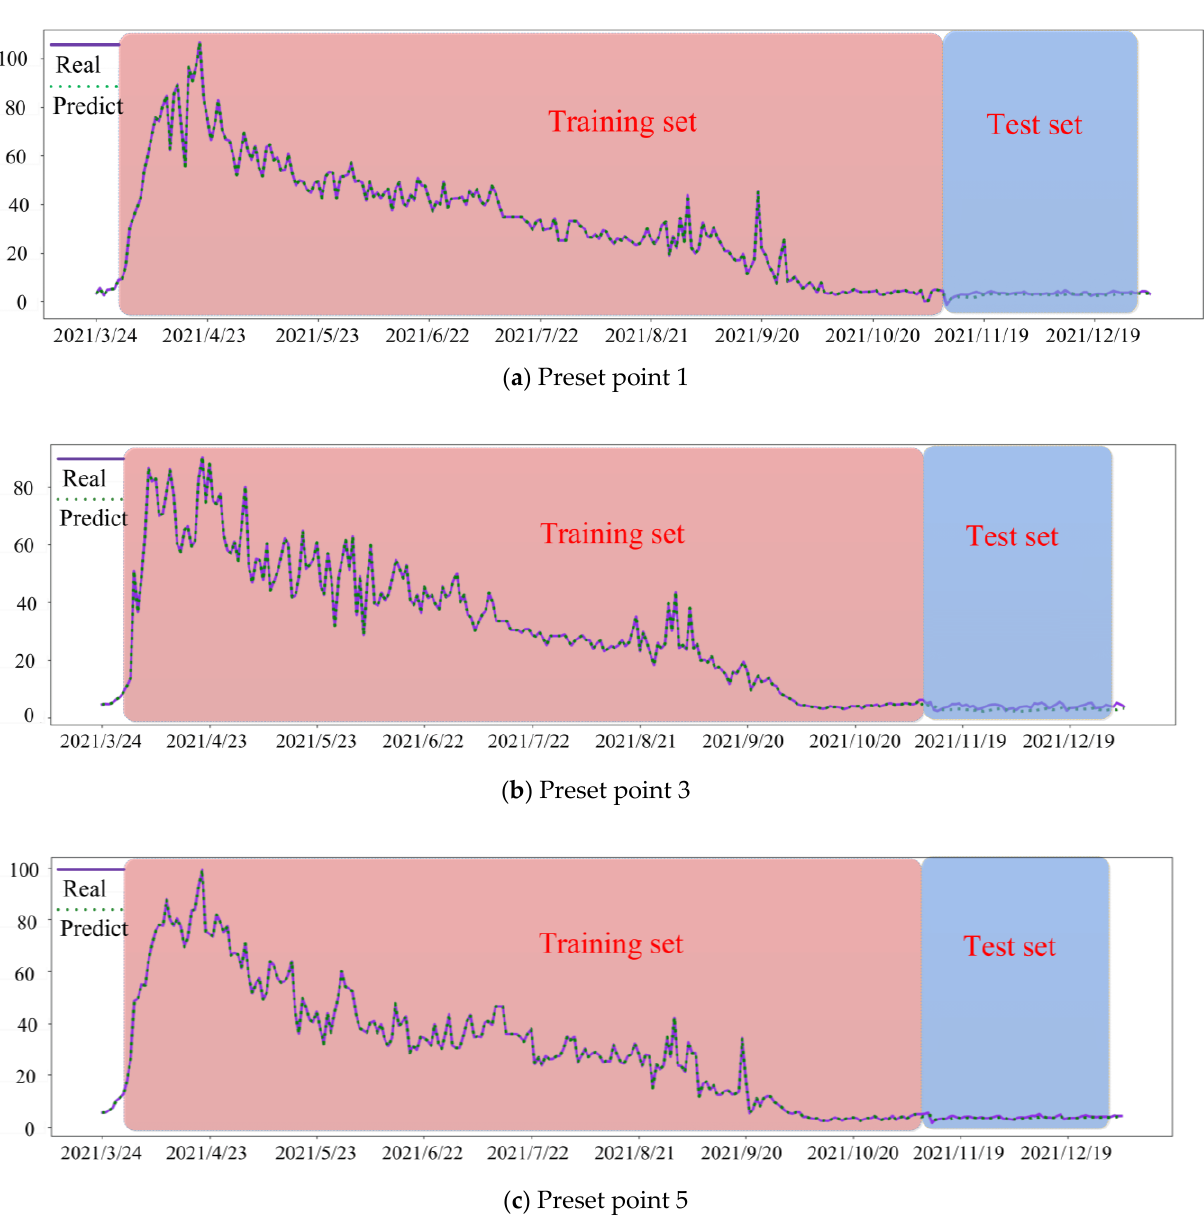
Figure 6. Test results of the GRU